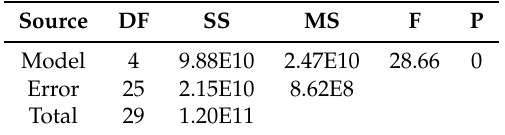
Table 8. ANOVA:Production volume vs. die-nozzle models.